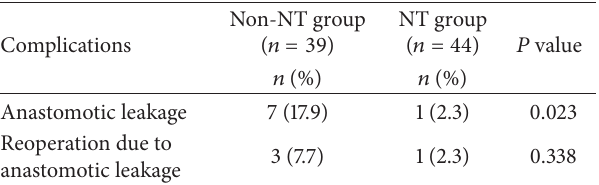
Table 4: Anastomotic